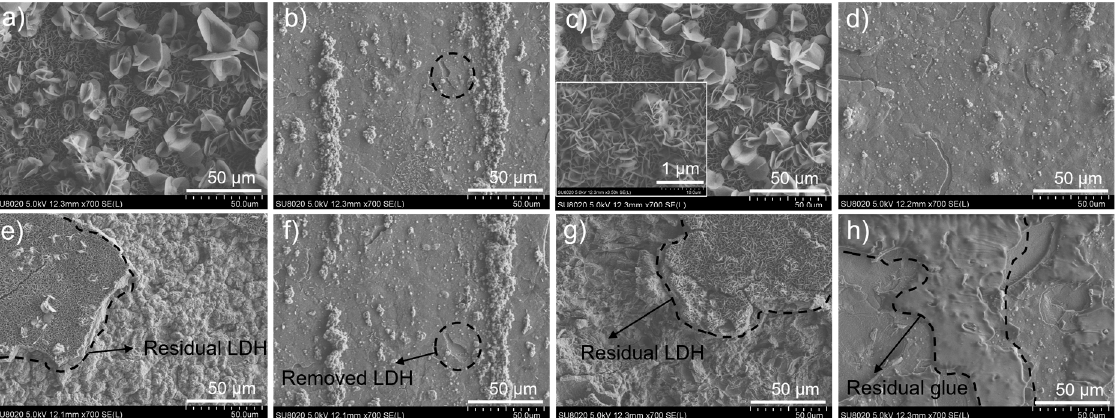
Figure 6. SEM images of ( a ) E1024, ( b ) E1124, ( c ) A1024, ( d ) A1124, before applying the tape and ( e ) E1024, ( f ) E1124, ( g ) A1024, ( h ) A1124 after peeling off. 3.2. Physical and Chemical Characteristics of LDH After Immersion in 0.1 M NaCl for 7 Days.